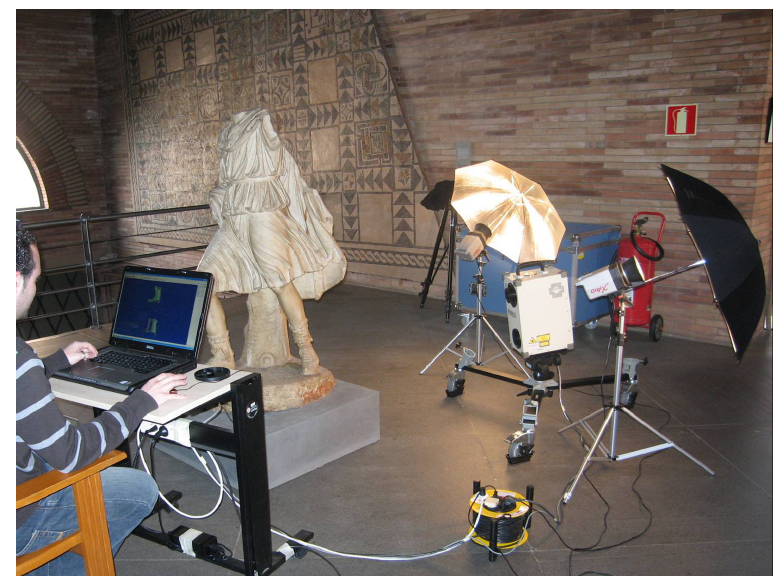
Figure 6. Moment of the scanning of Ascanius in the MNAR. The picture shows the lighting system used and the scanner mounted on a